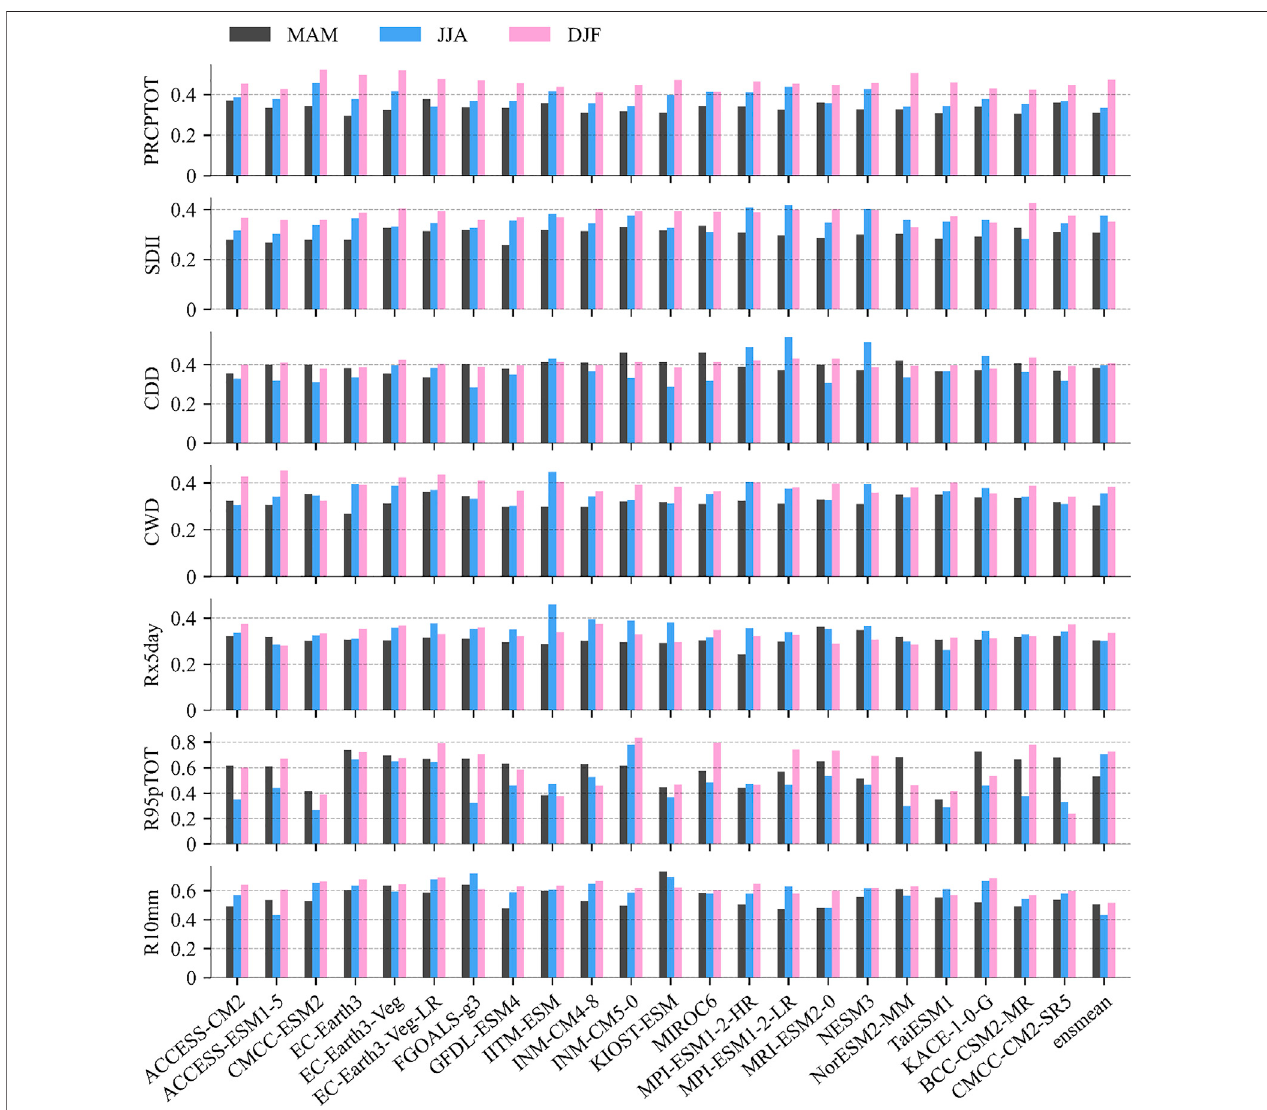
FIGURE 7 | Hellinger distance in mean and L-variation between the bivariate empirical densities of CMIP6 models and the GPM.